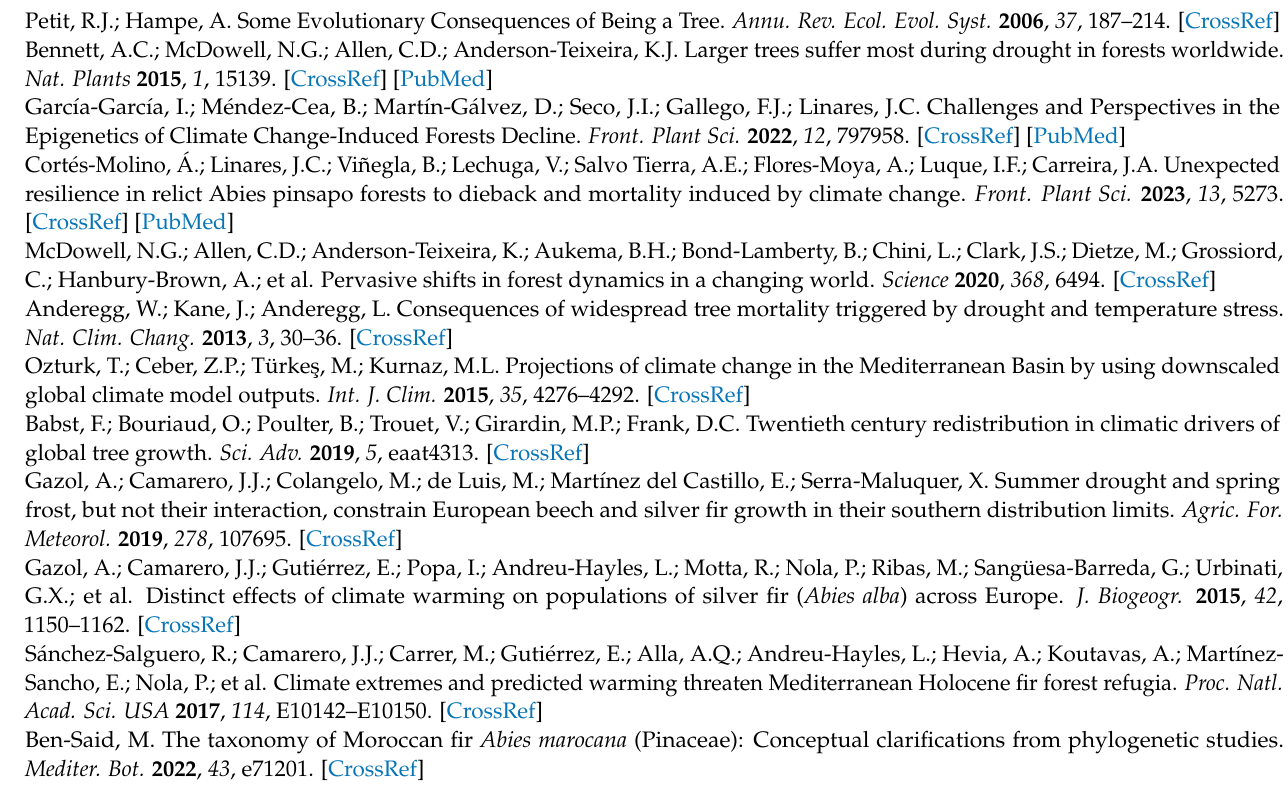
Table S2: Results obtained by AMOVA studies in Talassemtante and Tazaot populations. The rows indicate the partitions of genetic variability in two components: among and within populations. The columns show degrees of freedom (df), sum of squares (SS), mean squares (MS), estimate of variance (Est.var.), and the percentage of total variation (%). The percentage of variation is higher within individuals than among populations. Table S3: Results of the matches found in the alignments against protein database with those loci which were significant in BayeScan analysis comparing Abies marocana TA and TZ study sites for the identified SNPs; the sequence type, the name, and functions of the proteins, and the E-value are shown (lower values indicate increasing probability for the protein similarity). Protein functions were obtained from UniProt. The 4-digit number used as ID for the SNPs indicates the position in our genetic matrix. Table S4: Results obtained at protein level with those SNPs, which showed association with some variables in GPA studies. For the identified SNPs, the sequence type, the name and functions of the proteins, and the E-value are shown (lower values indicate increasing probability for protein similarity). Protein functions were obtained from UniProt. The 4-digit number used as ID for the SNPs indicates the position in our genetic